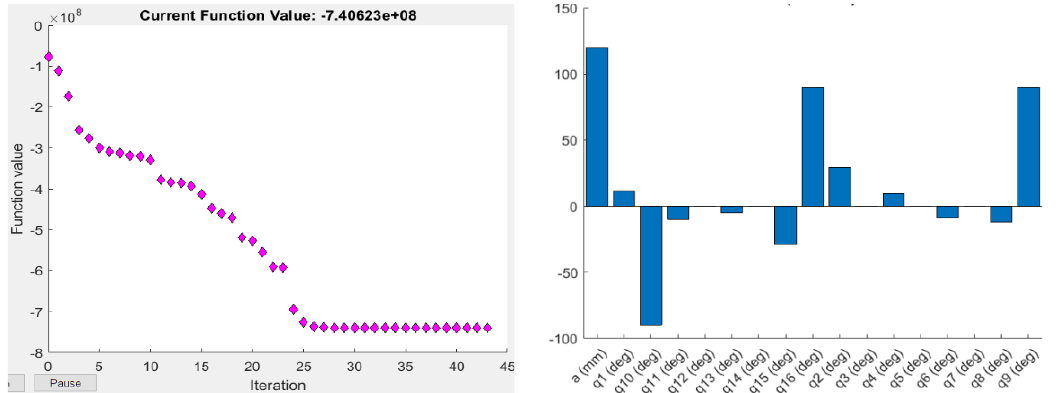
Figure 3. Objective function values ( left ), and the corresponding optimised joint parameters ( right ) for the best objective function value obtained by Fmincon for the Yoshikawa manipulability measure. Figure 4. Objective function values ( left ), and the corresponding optimised joint parameters ( right ) for the best objective function value obtained by ABC for the Yoshikawa manipulability measure.